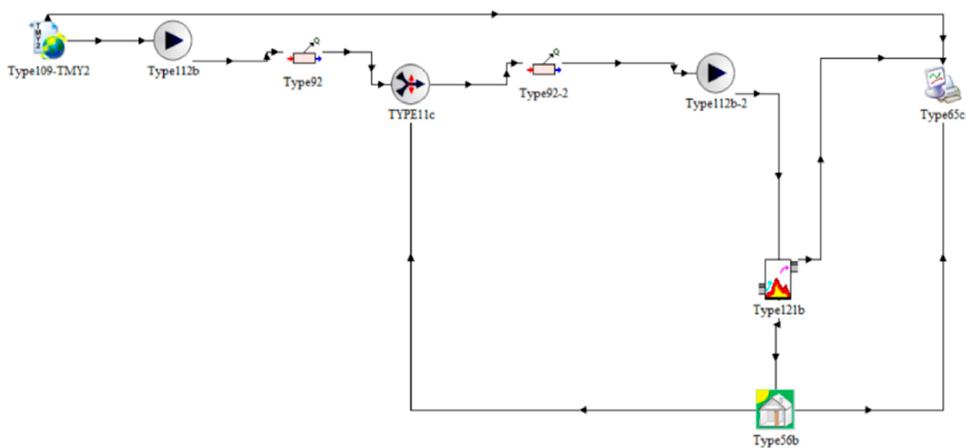
Figure 13. TRNSYS layout for option B.